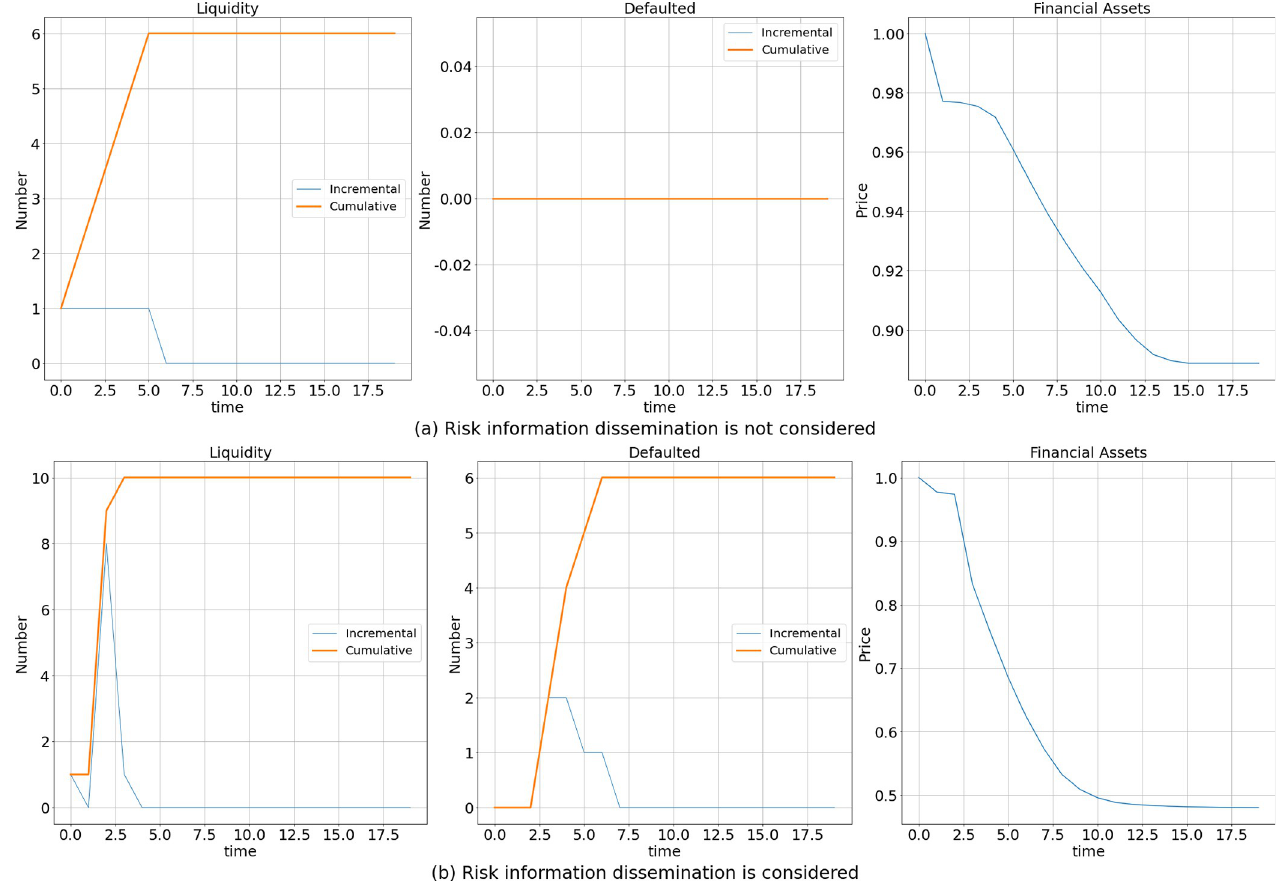
Fig 1. Effect of the existence of risk information dissemination.